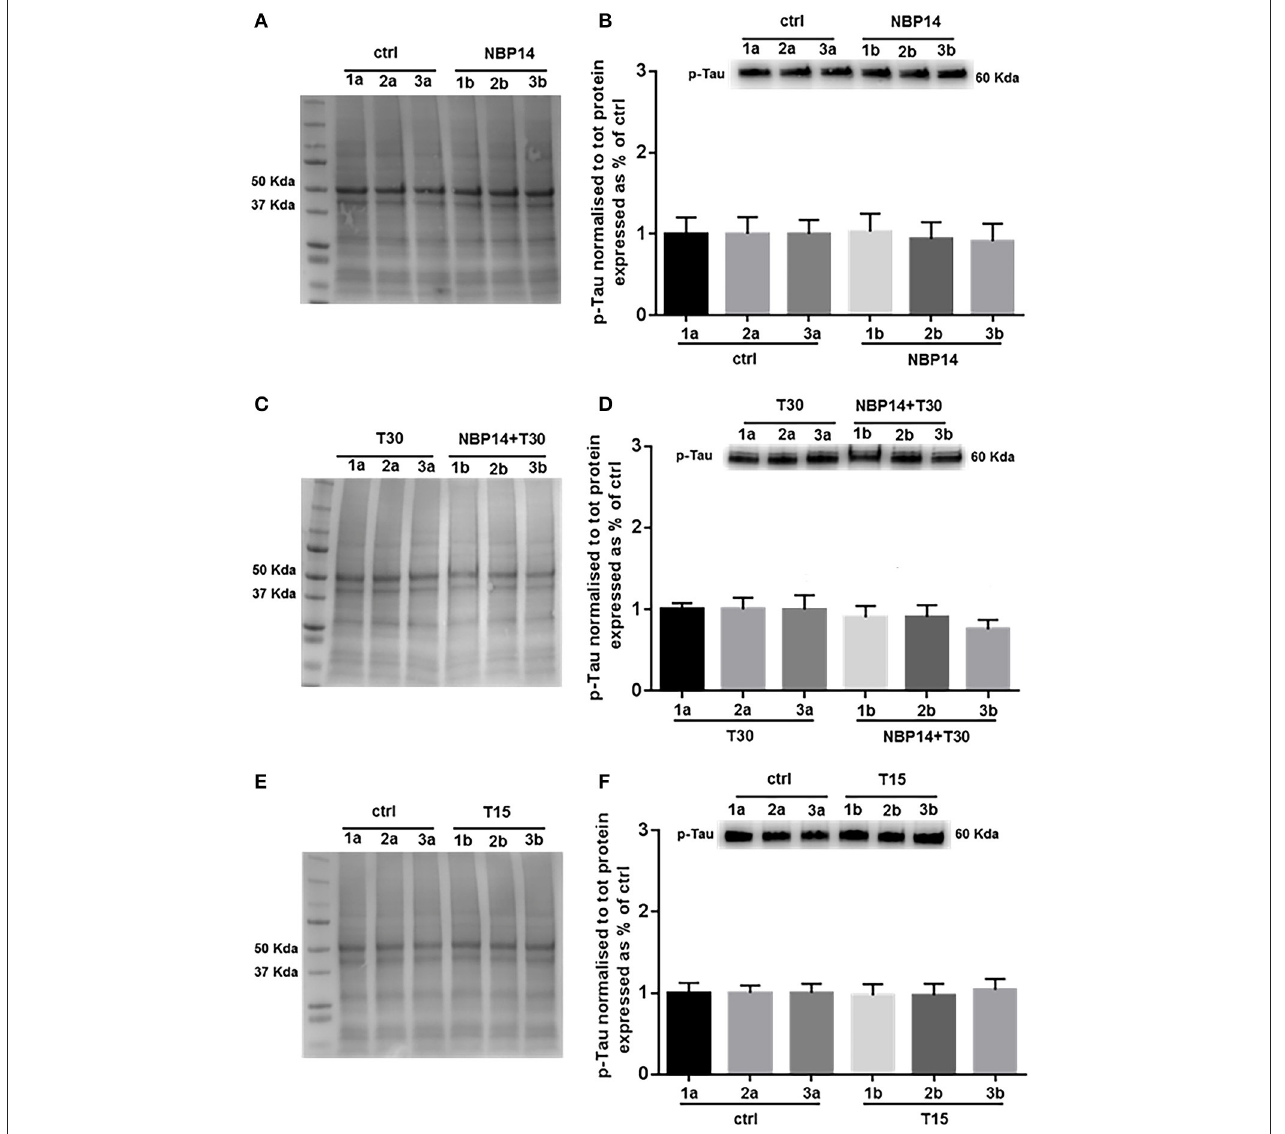
FIGURE 6 | Phosphorylated Tau levels show less variability along the basal forebrain axis following different treatments. (A,C,E) Representative total protein staining used as loading control. (B,D,F) Representative immunoblots and bar graphs indicating p-Tau levels along the three BF subdivisions. (A) Total protein membrane subsequently immunoblotted for p-Tau. (B) The BF regions showed no protein difference between conditions [ F (5, 55) = 0.4774, p = 0.7915, two-way ANOVA]. (C) Total protein membrane subsequently immunoblotted for p-Tau. (D) Phosphorylated Tau was unchanged between conditions and BF axis [ F (5, 35) = 1.837, p = 0.1310, two-way ANOVA]. (E) Total protein membrane subsequently immunoblotted for p-Tau. (F) Independently from the anatomical area and condition p-Tau showed similar levels [ F (5, 35) = 0.3212, p = 0.8968, two-way ANOVA]. Protein changes were indicated as mean ± SEM. n = (hemisections per condition, rats) in (A,B) are (36, 12); in (C,D) (24, 8); in (E,F) (24,